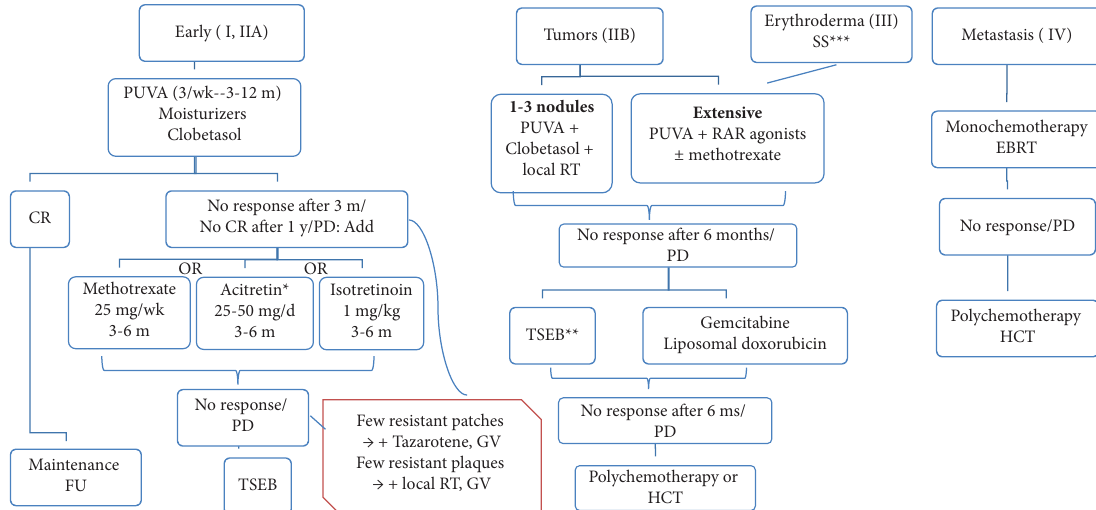
Figure 3: Algorithm for treatment of classic MF/SS. Te treatment is presented in a stepwise pattern where patients shift to the next line of